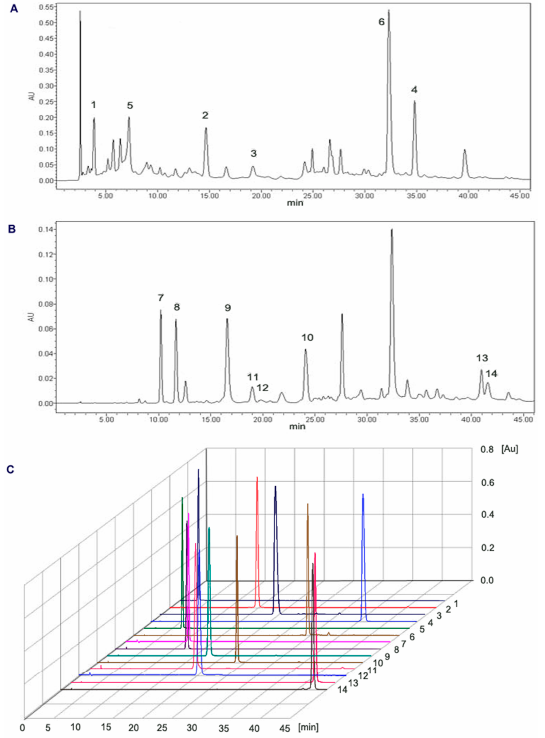
Figure 2. The results of HPLC analyses of EtOAc extract ( A ); the upper pumped from column tail ( B ) and purified pure compounds by pre-HPLC ( C ).